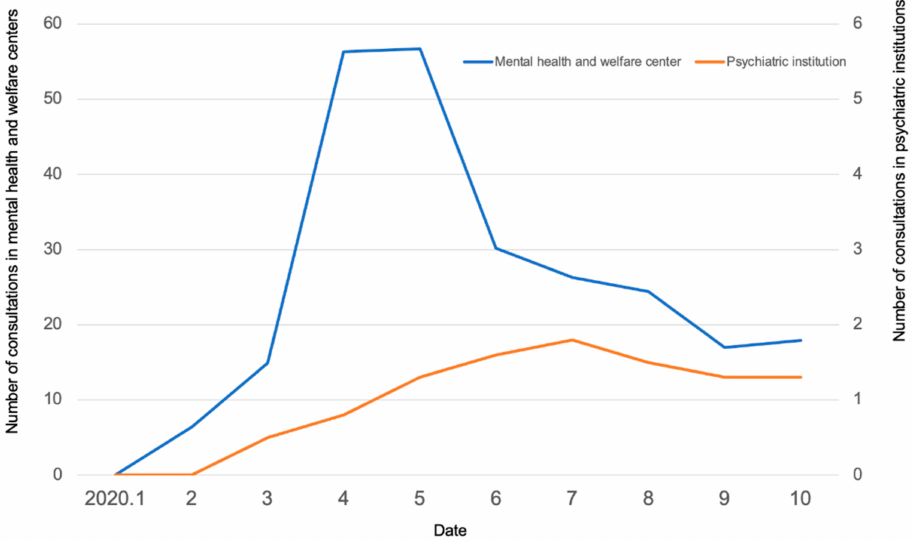
Figure 3. Number of consultations per month.